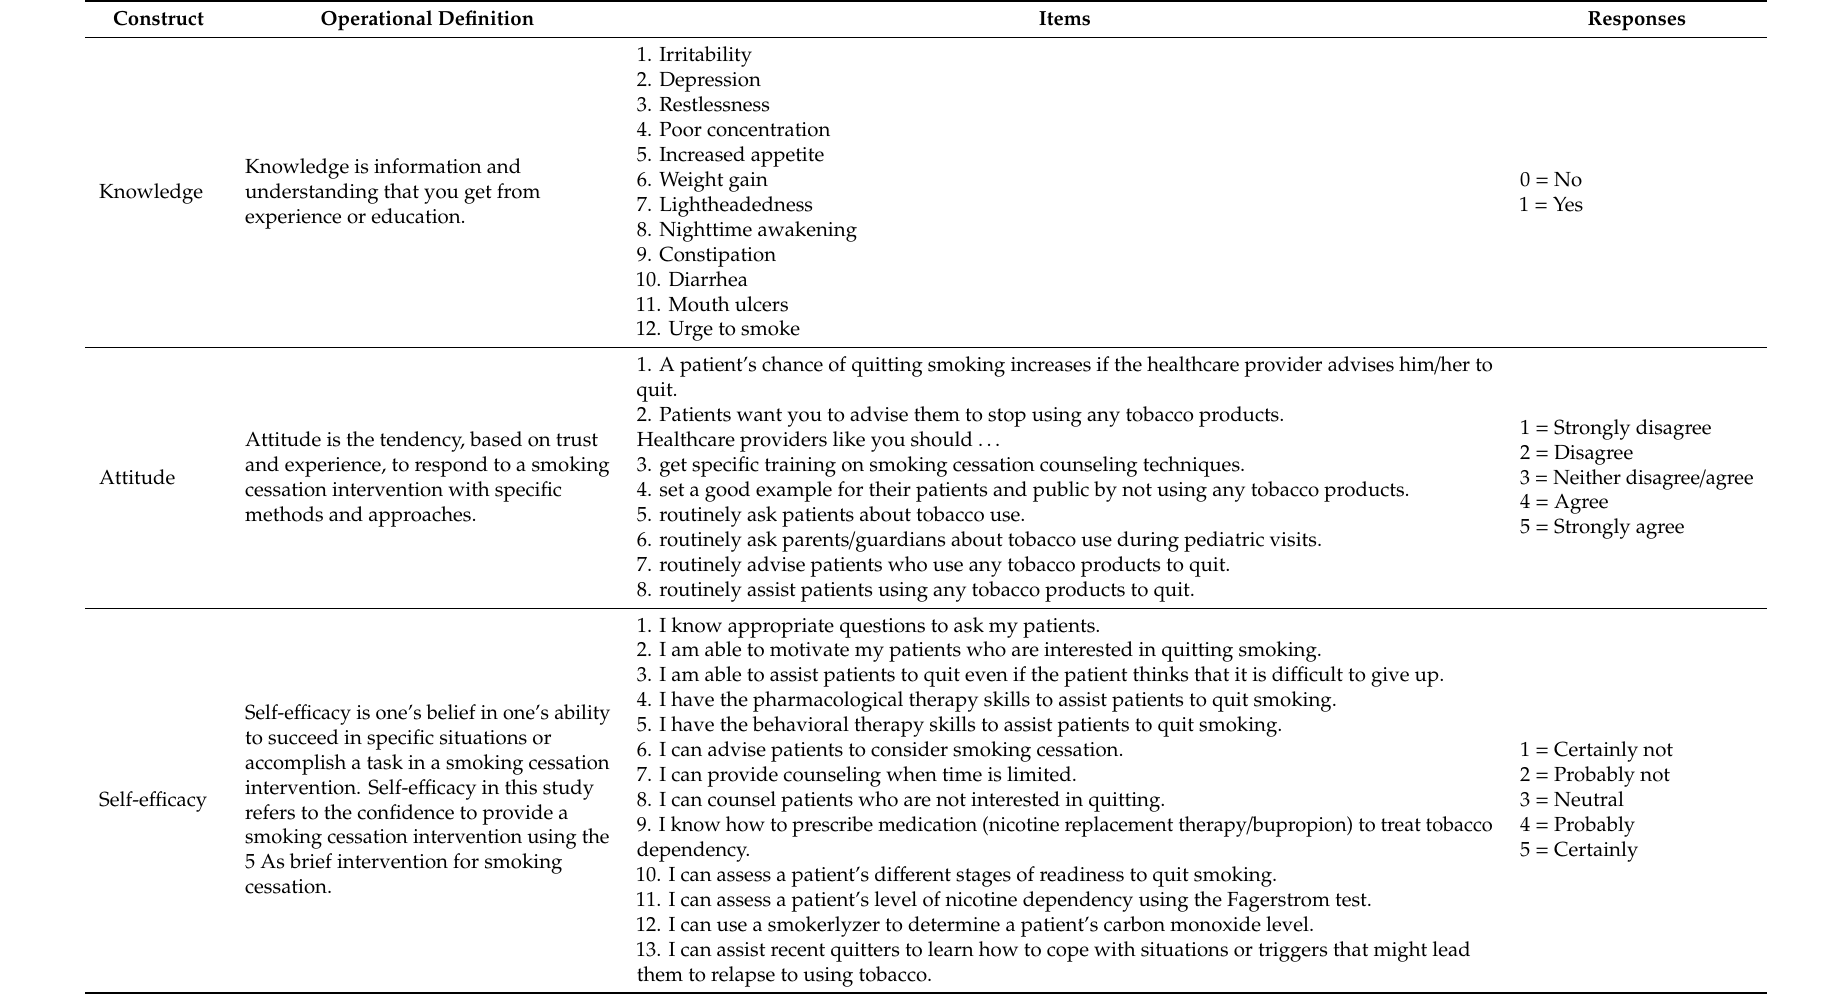
Table 1. Initial development of constructs and items in the Providers’ Smoking Cessation Training Evaluation